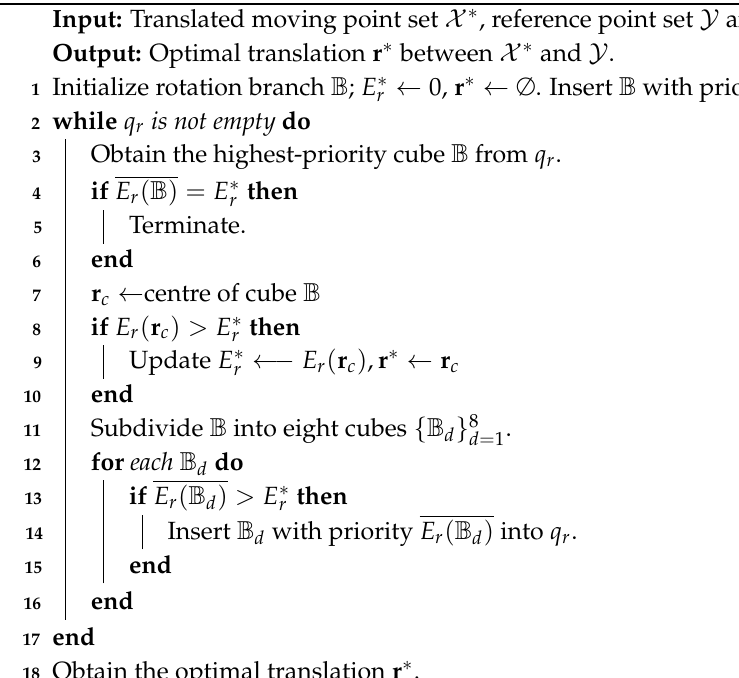
Algorithm 2: Globally Optimal Rotation